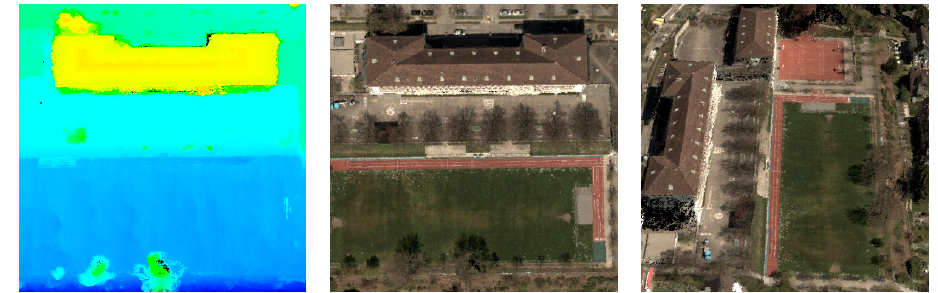
Figure 10. Multi-view dense matching results for difficult areas with sharp discontinuities, weak textures, or repeated textures.